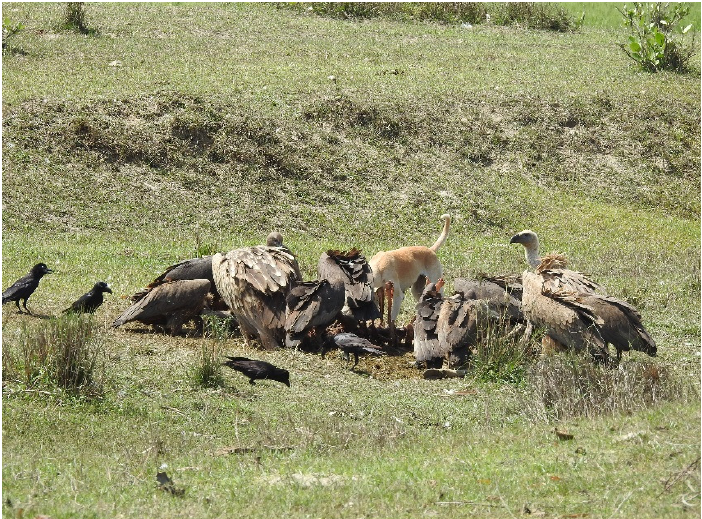
Figure 7. A wake of vultures (Himalayan Griffon and White-rumped Vultures) feeding on cattle carcass. Companion scavengers like, dog and crows can also be seen competing for the